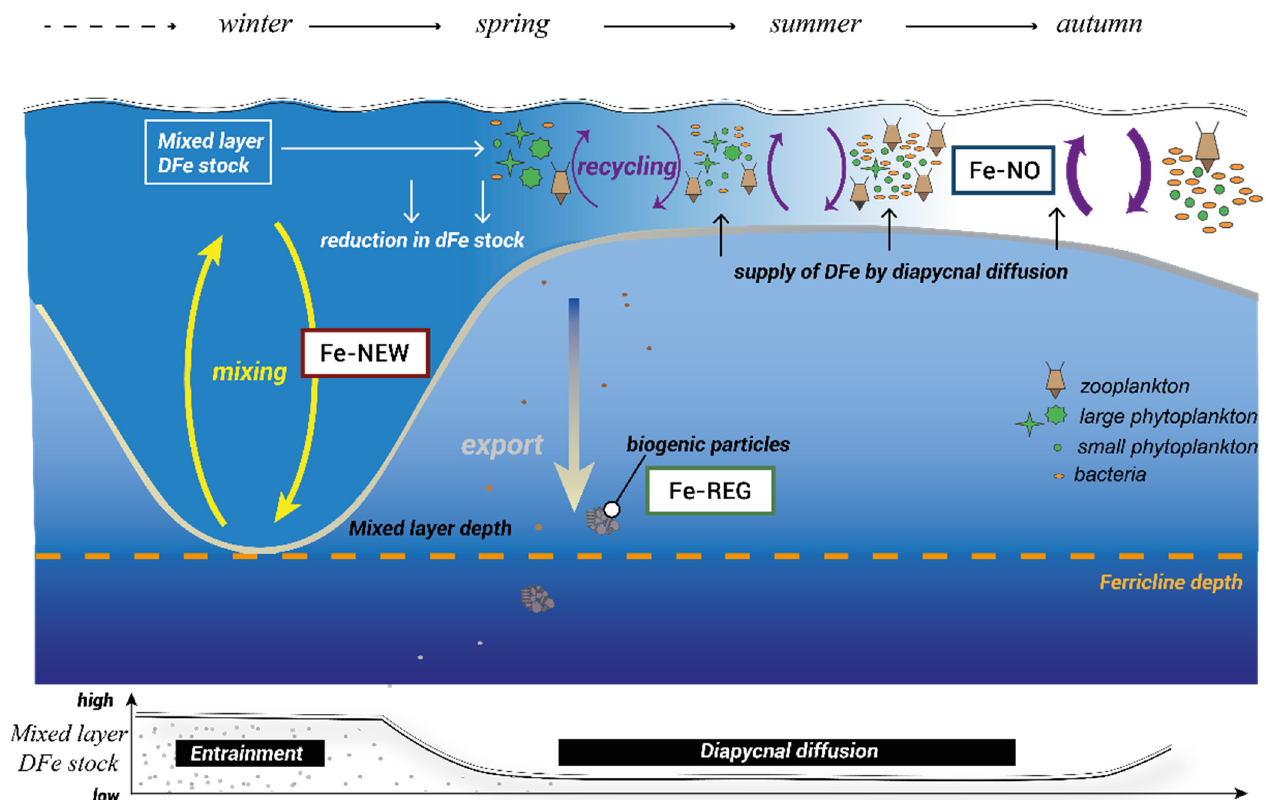
Figure 1. A schematic representation of the seasonal variability in Southern Ocean Fe cycling adapted from [3]. The dominant physical processes over the season are conceptualized at the bottom of the figure with the evolution of DFe inventories in the mixed layer. DFe sources (Fe-NEW, Fe-REG, and Fe-NO) used in this study aimed to represent the seasonal transition of modes of DFe supply from mainly new DFe early in the season (entrainment) to regenerated DFe from the recycling of sinking materials later during the summer (diapycnal diffusion) and to no DFe supply in the autumn.